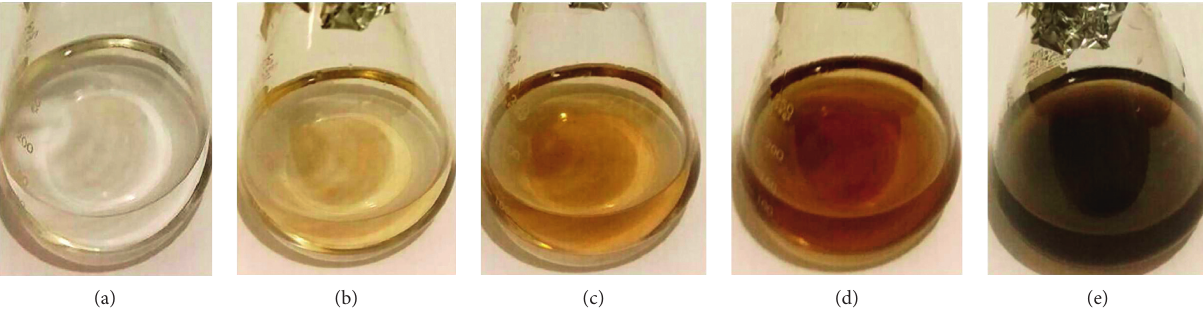
Figure 1: Different stages during the synthesis of AsNPs. (a) Transparent precursor solution indicated no color by the As 3+ ions formation. (b) Color of solution changed to light yellow by the addition of reducing agent due to the reduction process. (c-e) Further color change from light yellow to dark brown is owing to the nucleation and growth process leading to the formation of